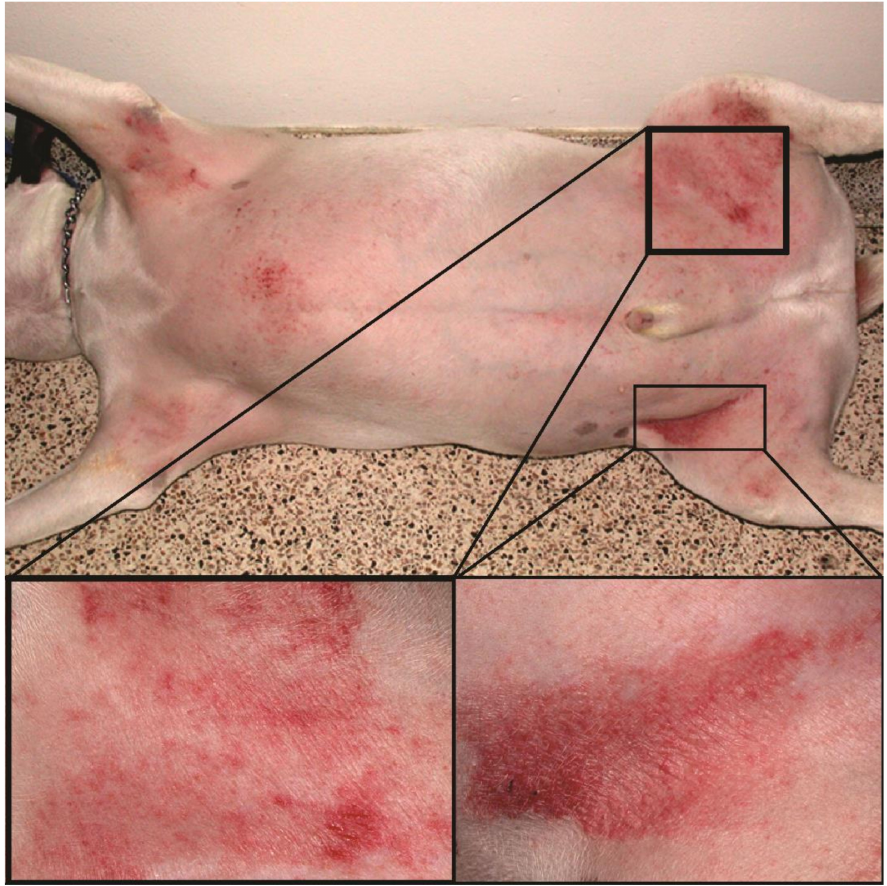
Figure 1. Atopic dog’s skin in the inguinal region with severe erythema and